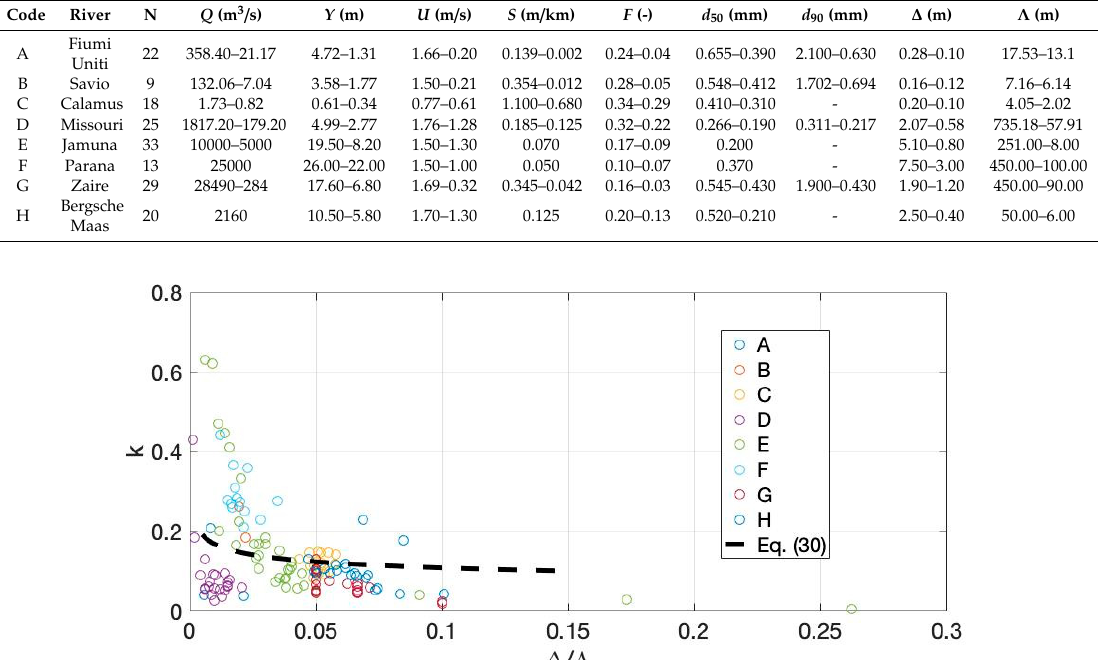
Figure 3. Empirical coefficient κ as a function of dune steepness δ = Δ / Λ . (Data A–H see Table 1).